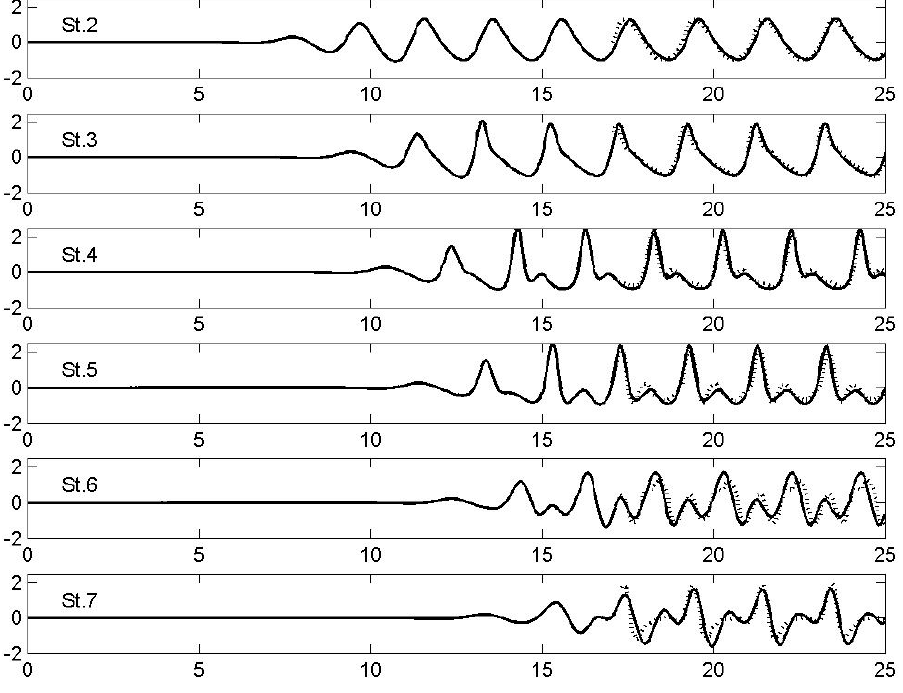
Figure 12. Comparison of present simplified nonlinear model results in the case of monochromatic waves of period T = 2 s propagating over the trapezoidal bar of Figure 9 against the experimental data by Beji and Battjes [27], shown by using dotted lines. Time series of free surface elevation measured at stations 2–7 of Figure